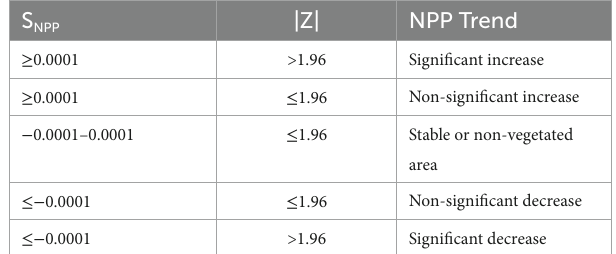
TABLE 2 Classification of NPP